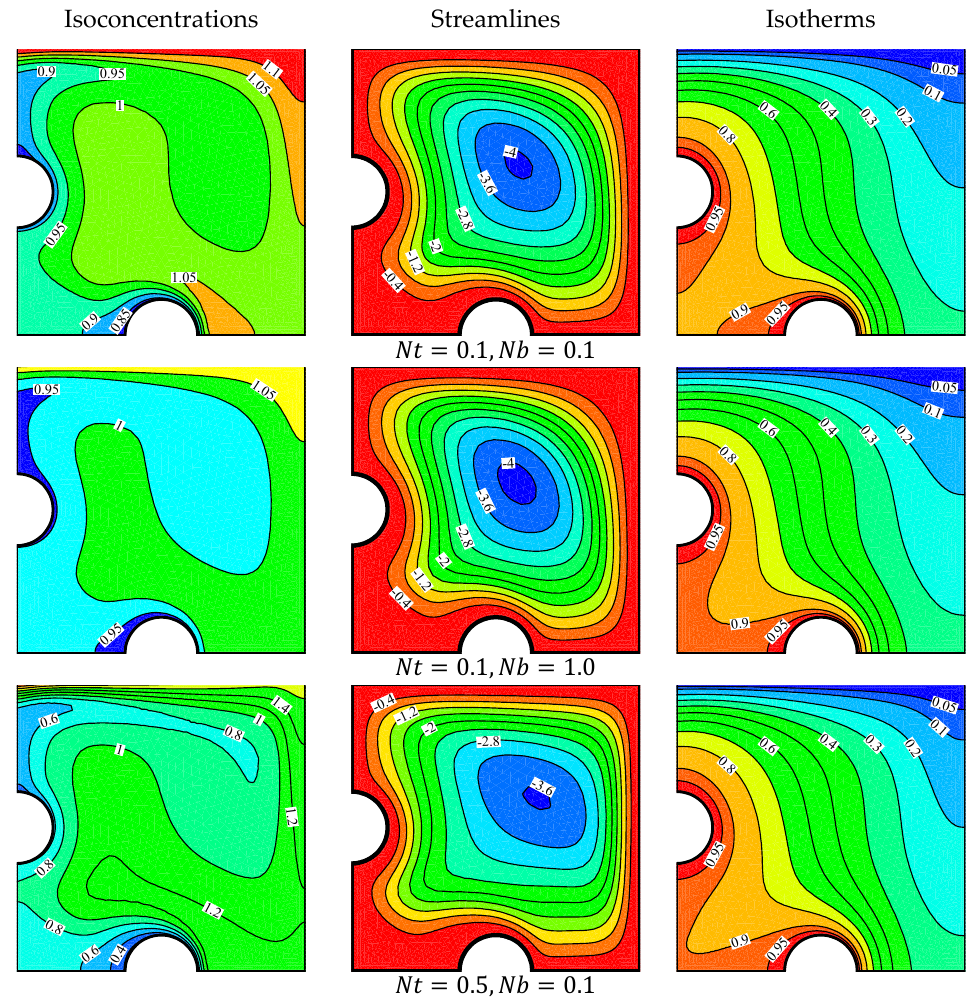
Figure 9. Nanoparticles isoconcentrations, streamlines, and temperature field at different 𝑁𝑡 and 𝑁𝑏 for γ r = 1, 𝑀𝑛 (cid:3033) = 1000 , 𝑅𝑎 = 10 , 𝑁𝑟 = 0.5,𝐻𝑎 = 20, and 𝐿𝑒 = 10 .